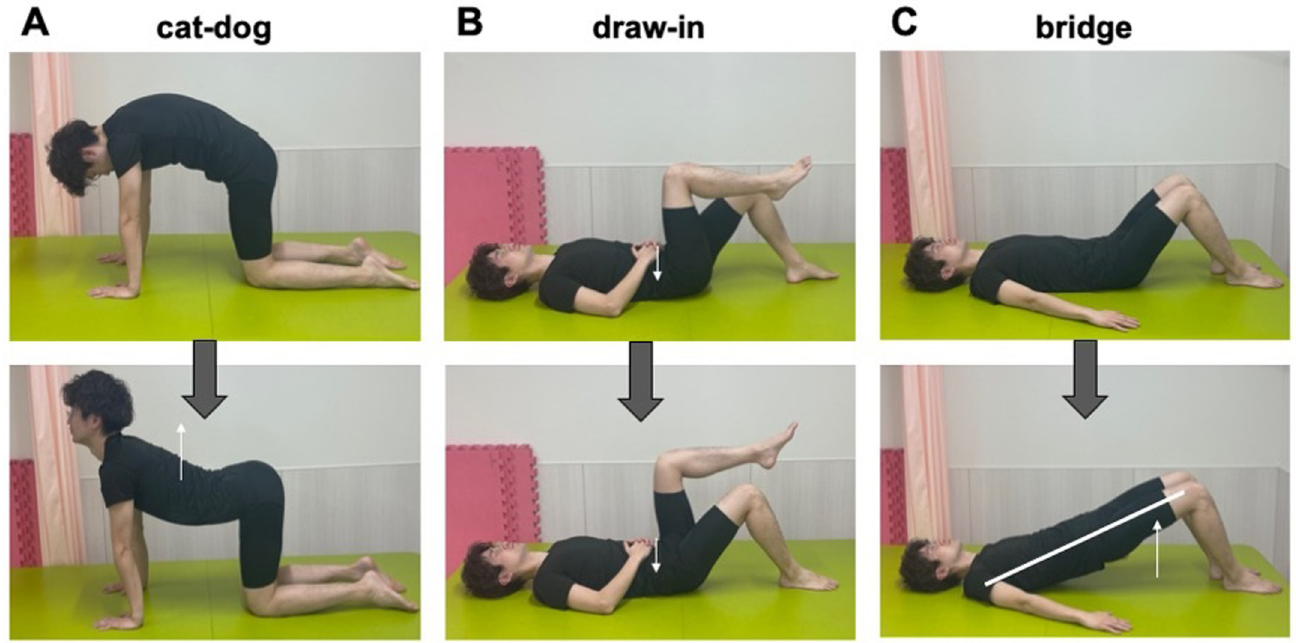
Fig 1. Schematic diagram of each self-motor-control exercise. A) Cat-dog. B) Draw-in. C) Bridge.